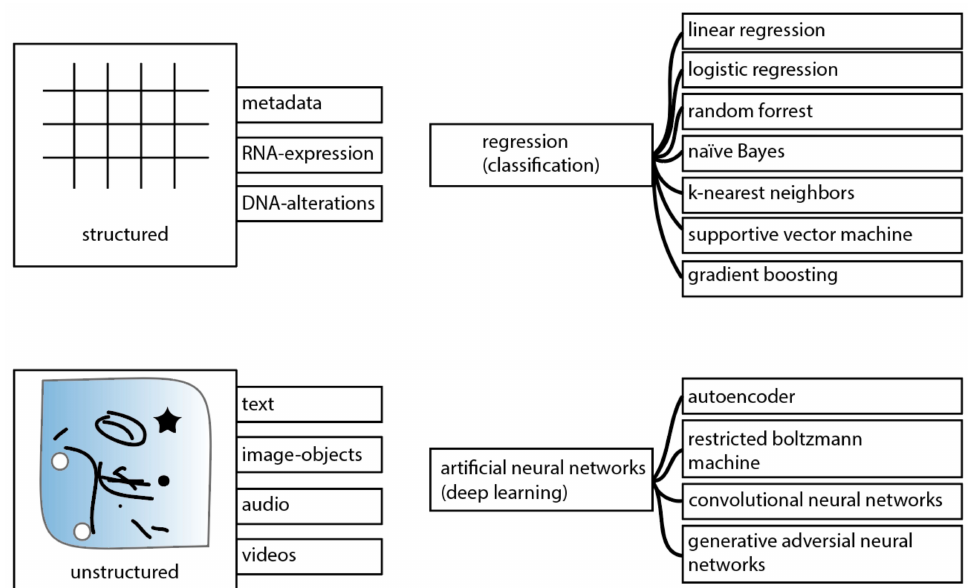
Figure 2. Overview of ML techniques that can be applied using an unsupervised learning approach. Regularly, tabular data (structured data), including genomics data are analyzed using regression or classification models. Notably, also structured data can be analyzed using deep learning (DL). As for unstructured data, where complexity increases, DL models are used in favor of regression/classification models. In particular, the field of computer vision and image analysis has shifted greatly to